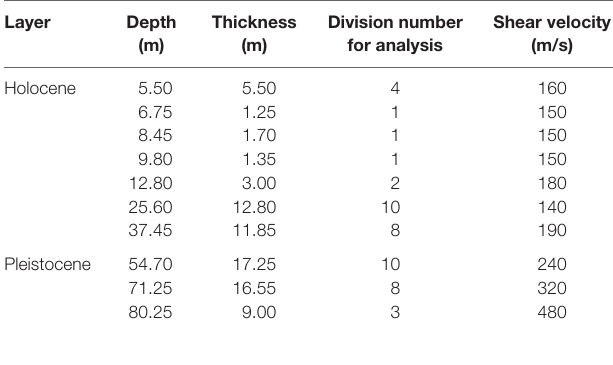
TaBle 1 | Parameters of soil underlying the Tokyo Bay area.